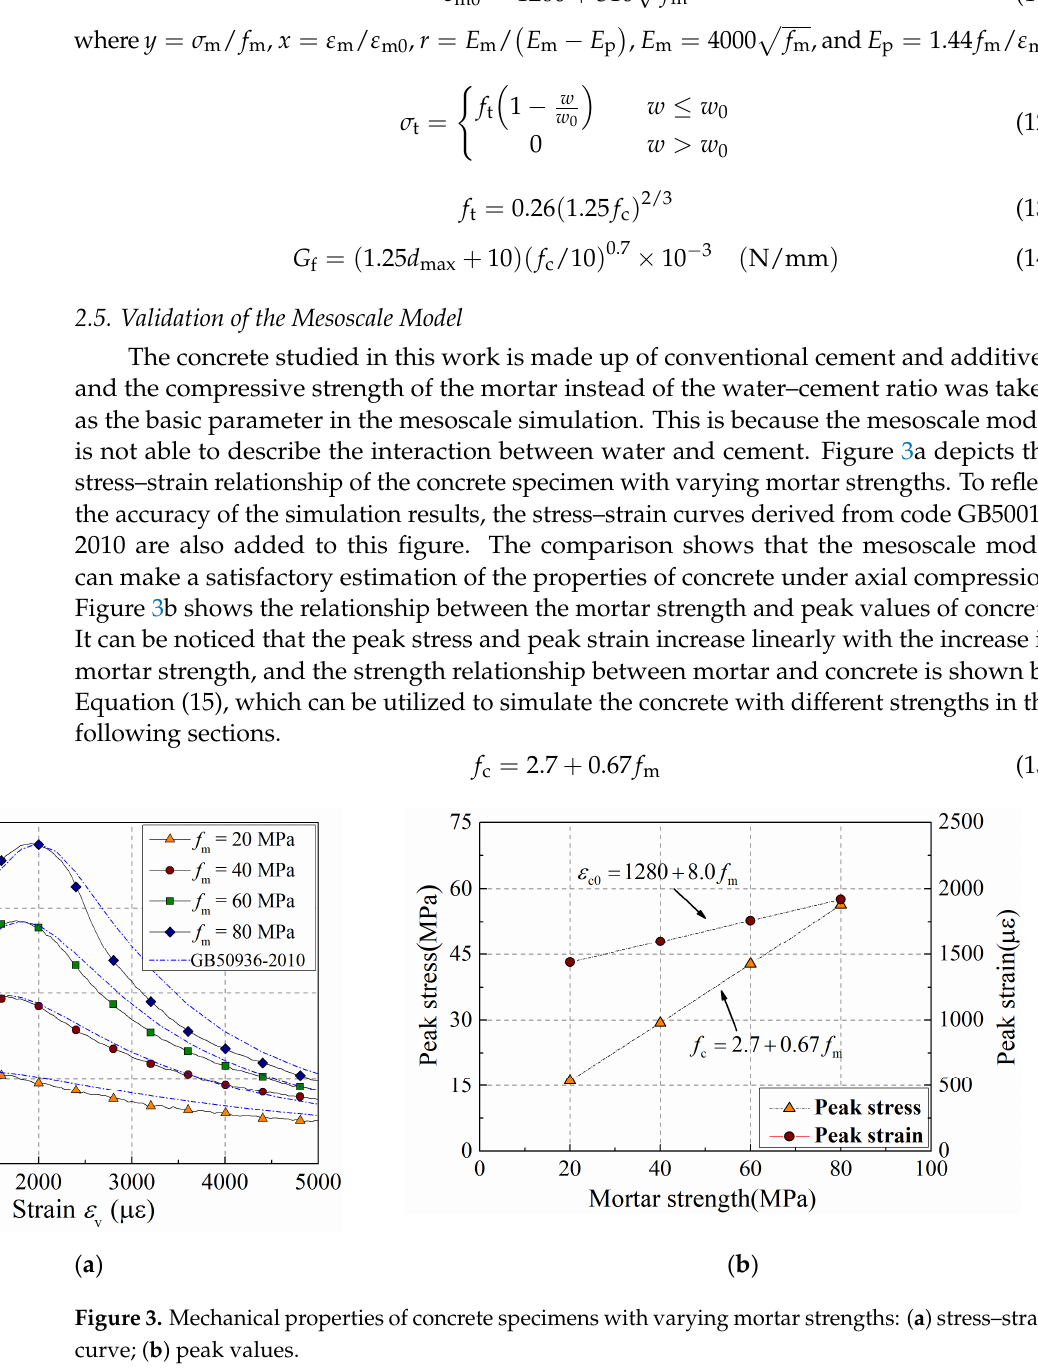
( e ) Figure 4. Comparison of the lateral–axial strain relationship: ( a ) f c = 26 Mpa; ( b ) f c = 35.8 Mpa; ( c ) f c = 40/60 Mpa; ( d ) f c = 50 Mpa; ( e ) f c = 68 MPa. Figure 4 shows the comparison of the lateral–axial strain relationship between the simulation and test results in the middle section of the specimen. The established model can make an adequate prediction of the development trend of the lateral–axial strain